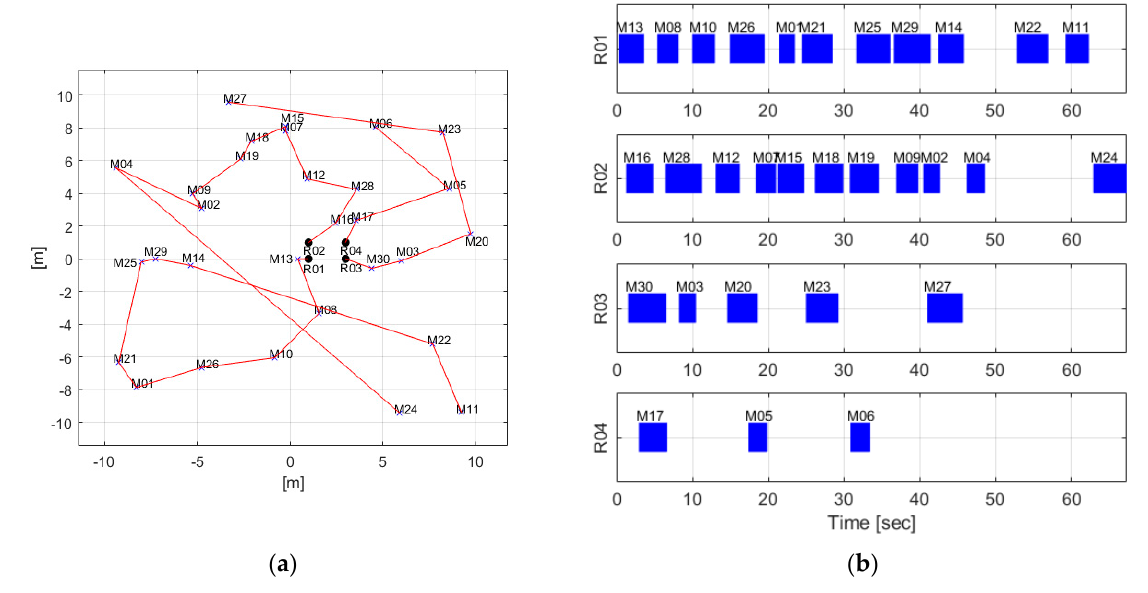
Figure 4. The results for medium case using CBBA: ( a ) 2D situation map; ( b ) timetable.